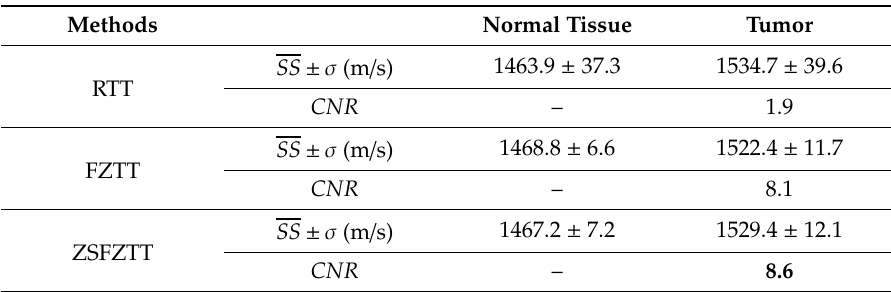
Table 6. The 𝐶𝑁𝑅 measured in SS image of the patient’s breast reconstructed by the RTT, FZTT, and ZSFZTT methods.